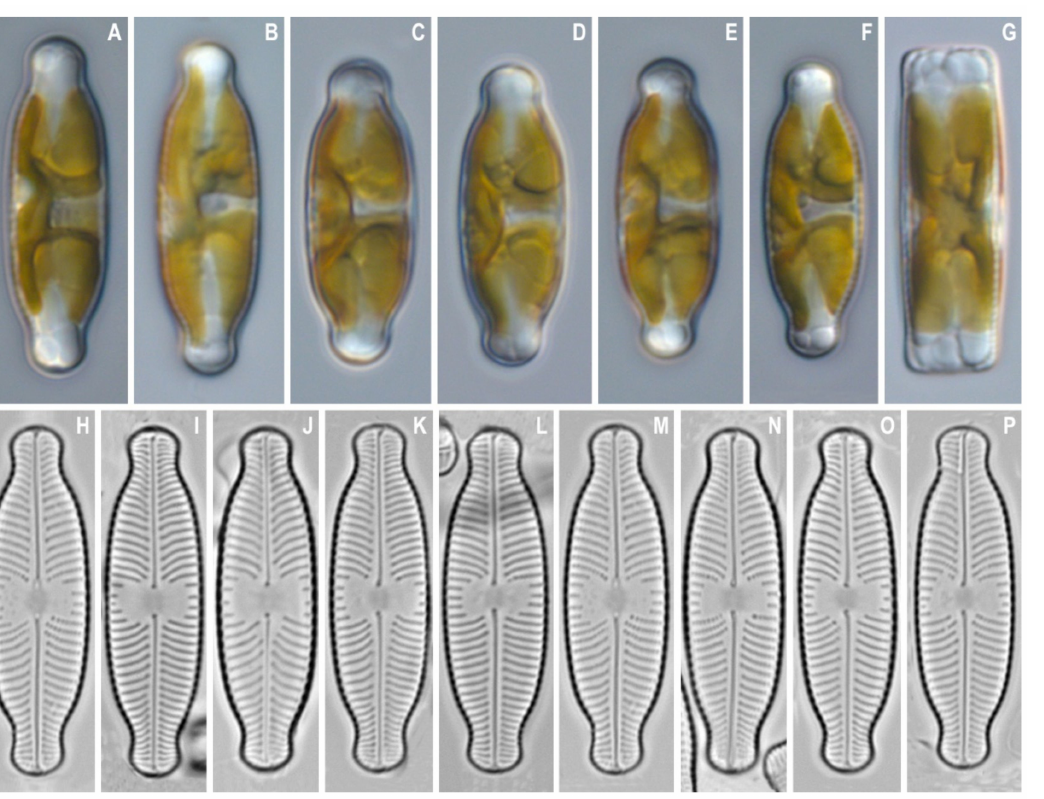
Figure 1. Placoneis baikaloelginensis Kezlya, Glushchenko, Kulikovskiy & Kociolek sp. nov. Strain B 703, slide No. 01493. Light microscopy, differential interference contrast, size diminution series. ( A – F , H – P ). Valves face. ( G ). Cell in girdle view. ( A – G ). Live cells with chloroplast structure. ( H ). Holotype. Scale bar = 10 µ